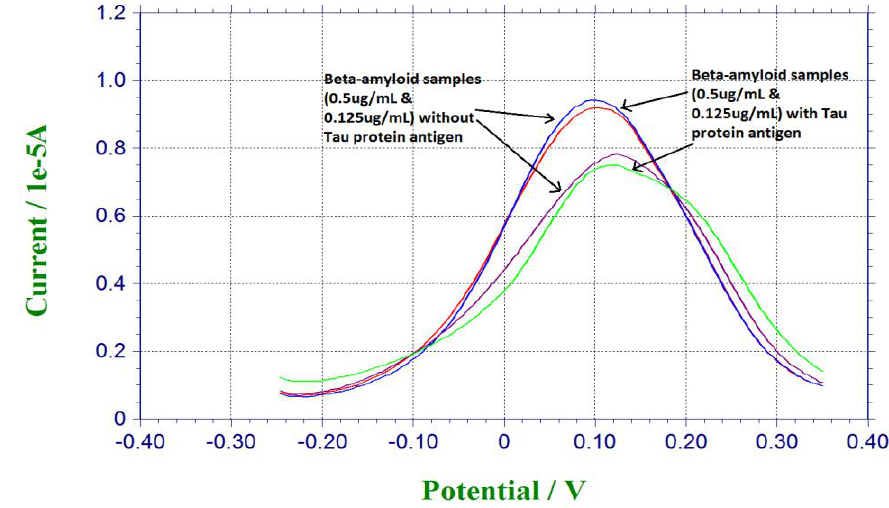
Figure 4. Interference study based on Tau protein antigen.